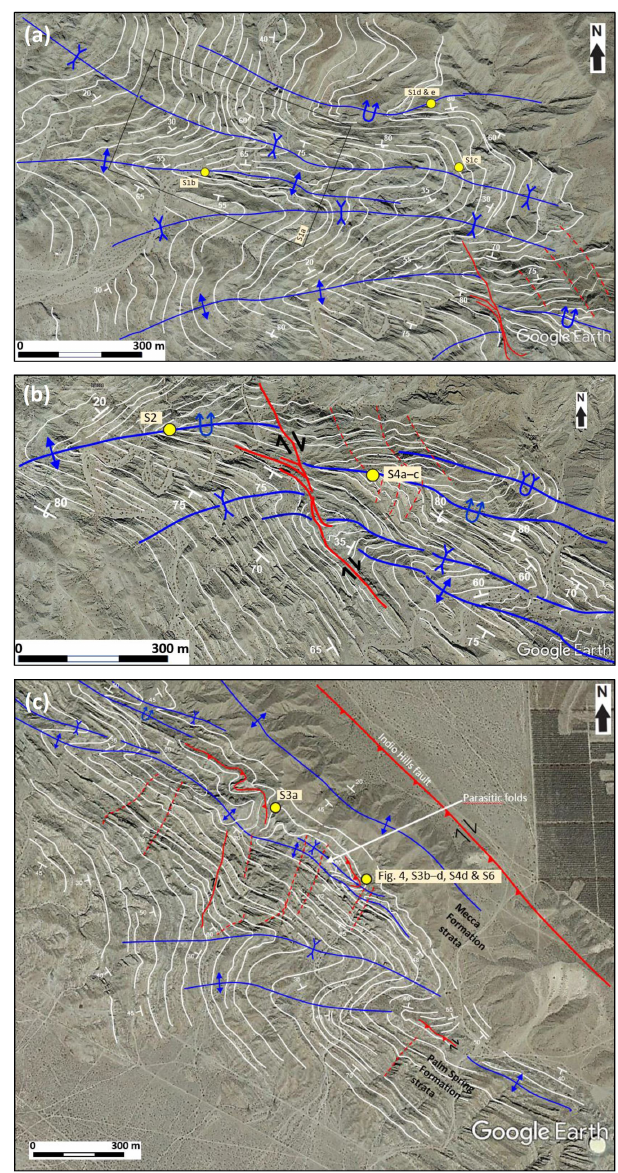
Figure 3. Detailed structural maps showing the architecture and outline of anticline–syncline pairs, traces of bedding and strike and dip orientation, axial surface traces, and fold-related faults in (a) the northwestern, (b) central, and (c) southeastern macro-folds. Note tighter and consistently asymmetric (Z-shaped) geometries of the macro-folds to the east, whereas folds to the west are more open and symmetric. Traces and orientation of bedding show a back limb composed of attenuated shear folds merging from the central macro- fold in the north, whereas the fore-limb is much shorter and more regularly folded. The yellow dots show the location of field pho- tographs. See Fig. 2 for legend and location. Uninterpreted version of the images available as Fig. S2a–c. © Google Earth